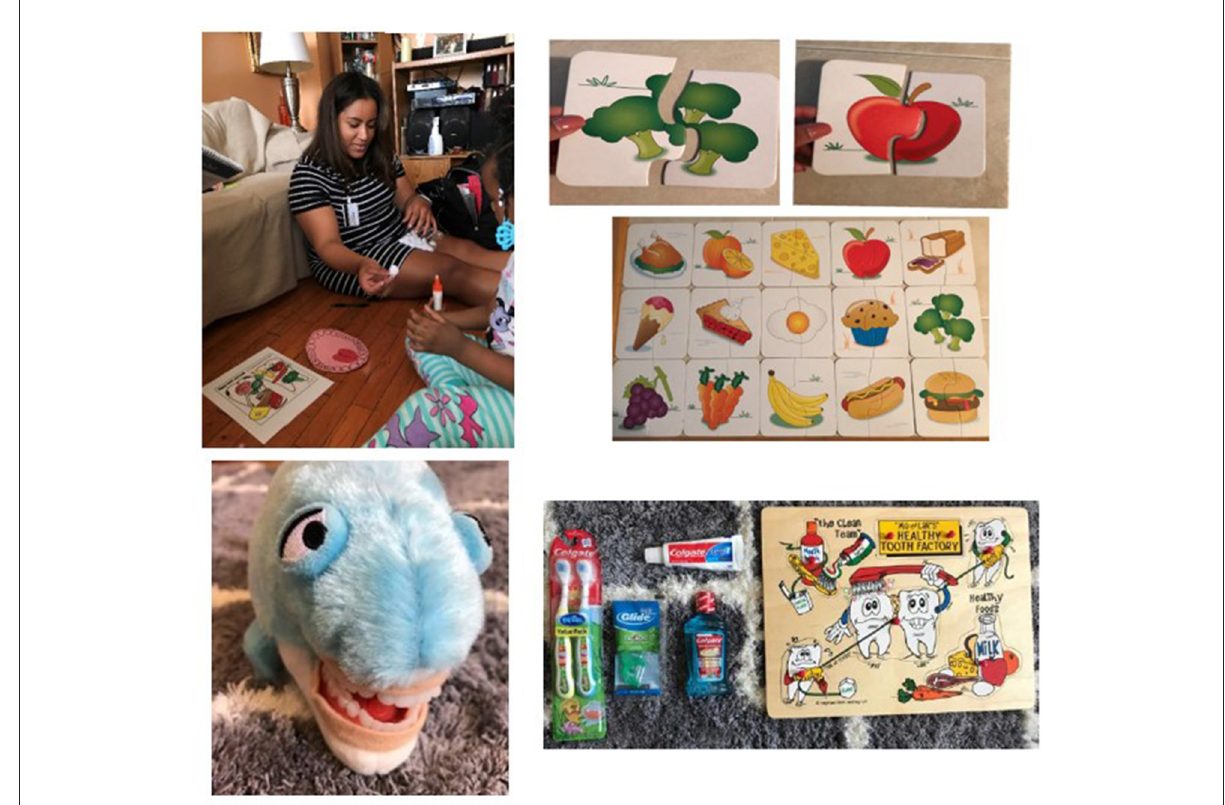
FIGURE1 Child-based oral health education. Oral community health worker-led interventions included game or play-based activities that related to oral health topics such as tooth brushing technique and dietary choices.